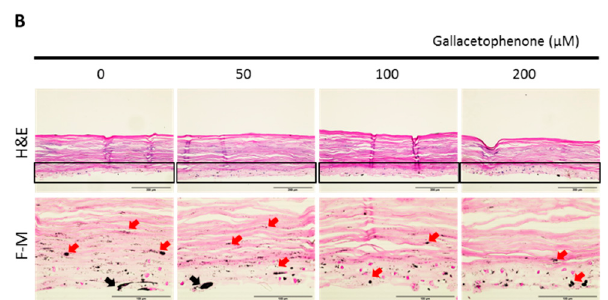
Figure 4. Optical and histological examination of whitening effects of gallacetophenone on 3D human skin equivalent. ( A ) Image of human skin equivalents; epidermal pigmentation level in skin equivalent was calculated by comparing variations in L* values ( Δ L). Kojic acid was used as a positive control; ( B ) H&E (scale bar =200 μ m) and F-M staining (scale bar=100 μ m) were performed for histological examination. Black squares indicate transferred melanin. Data are expressed as the mean ± SD of at least three independent measurements (* p < 0.05).